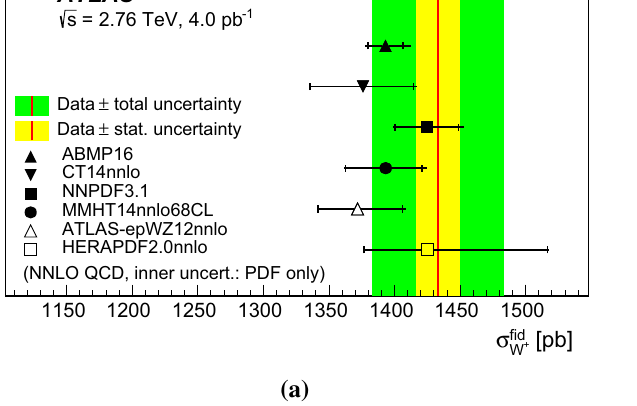
represents the statistical uncertainty only, the outer band corresponds W + to the experimental uncertainty (including the luminosity uncertainty). The theory predictions are given with the corresponding PDF (total) uncertainty shown by inner (outer) error bar